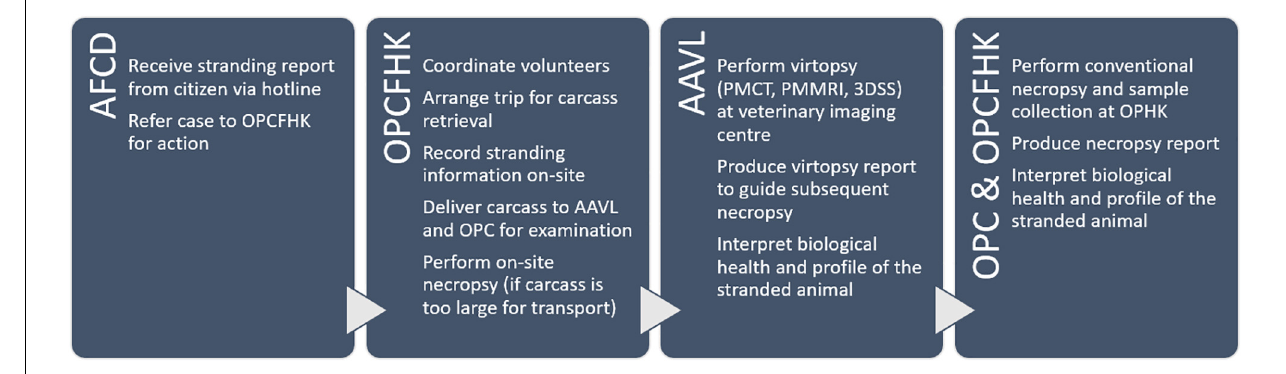
FIGURE 2 | Workflow of the current